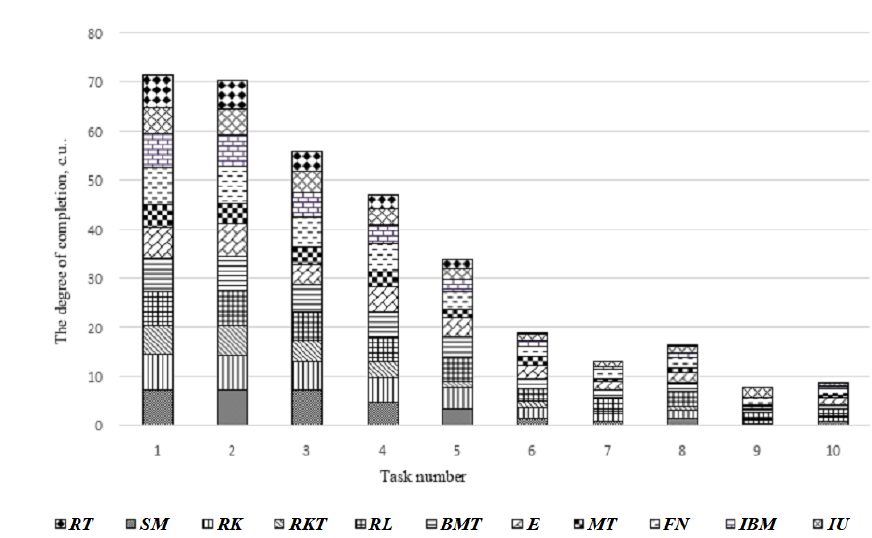
Fig. 1. The average mark for the tasks solved in all BMSTU faculties in 2018 and 2019 years.